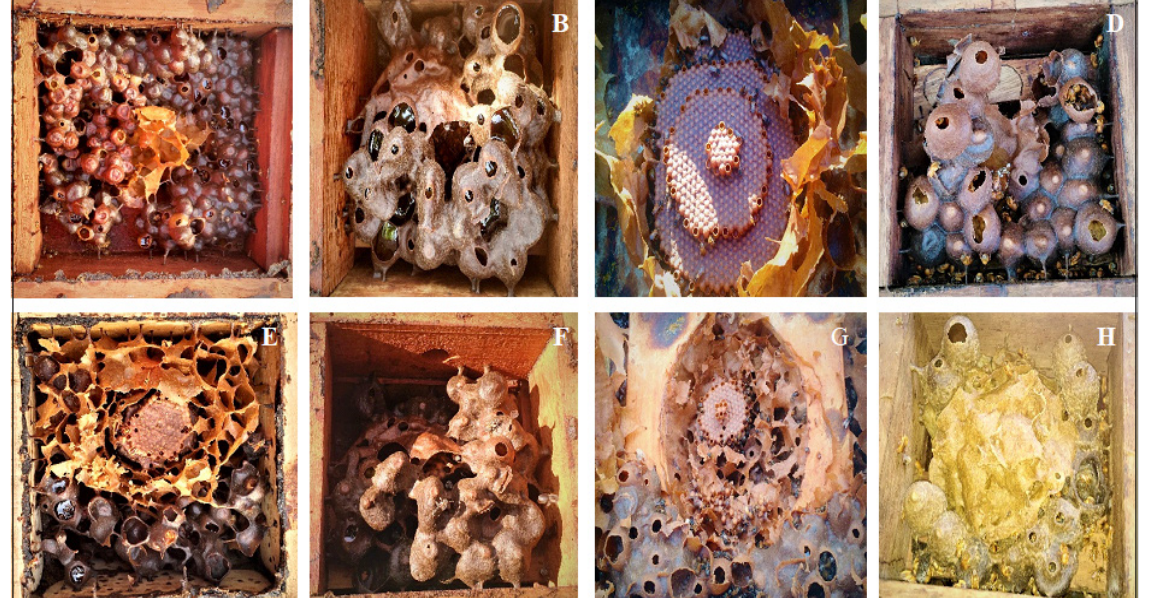
Fig 1 . Bee Colonies of the species: Tetragonisca angustula (A and E), Melipona fasciculata (B and F), Scaptotrigona tubiba (C and G) and Melipona rufiventris (D and H) in the municipalities of Palmas and Miracema,